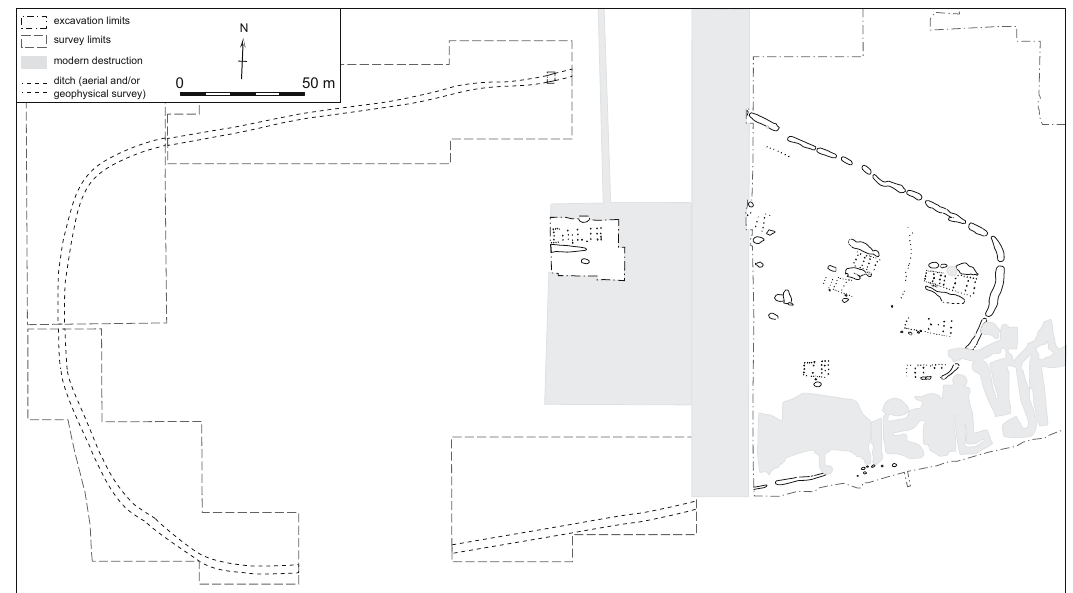
Figure 2: Menneville “ Derrière le Village, ” Dép. Aisne, France. Plan of the enclosure and settlement ( excavations 1976 – 1978